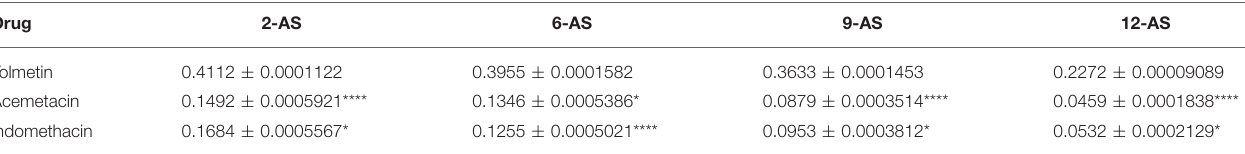
TABLE 3 | Values of NSAID concentrations (M) required to obtain 25% of fluidizing effect (FE 25 ) in the lipid nanocarriers MLVs of EPC (500 µ M, pH 7.4) labeled with n -AS probes. Drug 2-AS 6-AS 9-AS 12-AS Tolmetin 0.4112 ± 0.0001122 0.3955 ± 0.0001582 0.3633 ± 0.0001453 0.2272 ± 0.00009089 Acemetacin 0.1492 ± 0.0005921**** 0.1346 ± 0.0005386* 0.0879 ± 0.0003514**** 0.0459 ± 0.0001838**** Indomethacin 0.1684 ±